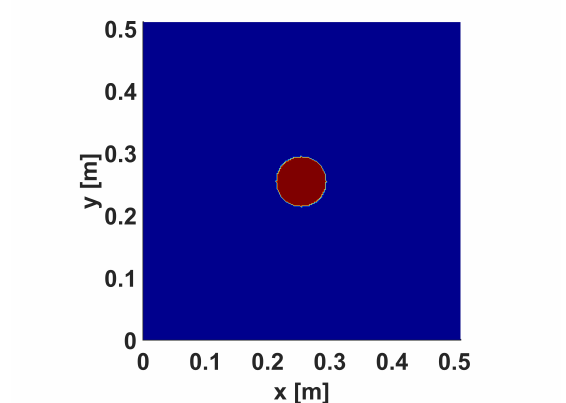
Figure 18. Amplitude distribution of the idealized circular piston